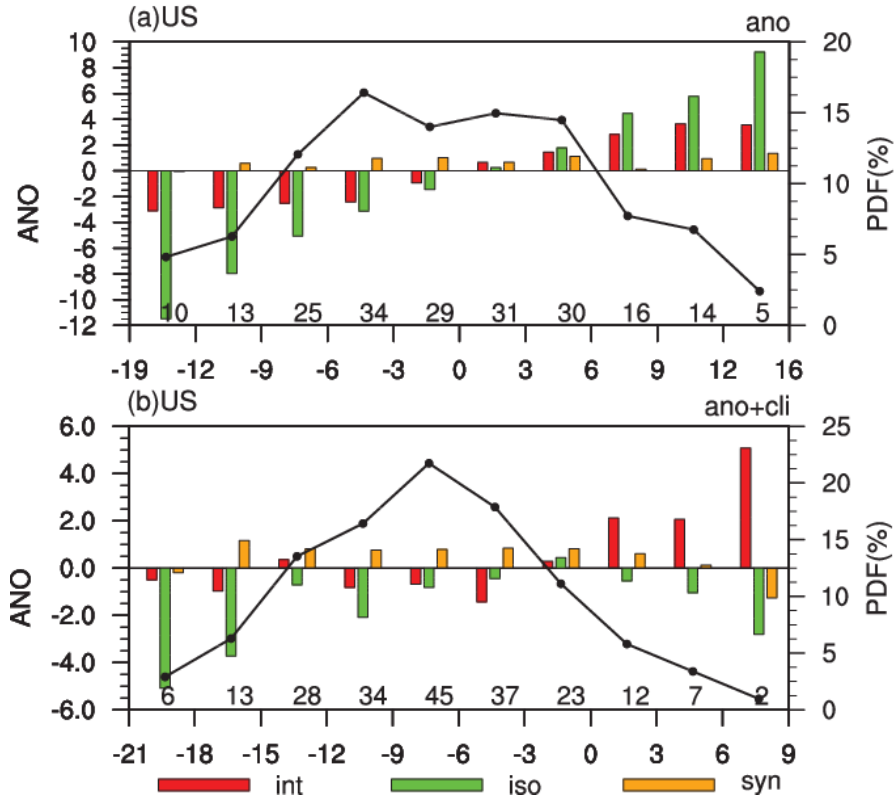
Figure 3. Same as Figure 2, except for ( a ) daily anomalies of vertical zonal wind shear (m s − 1 ) on interannual (red bar), intraseasonal (green bar), and synoptic (orange bar) time scales. ( b ) The same as ( a ) except that the bins are grouped based on total vertical zonal wind shear.